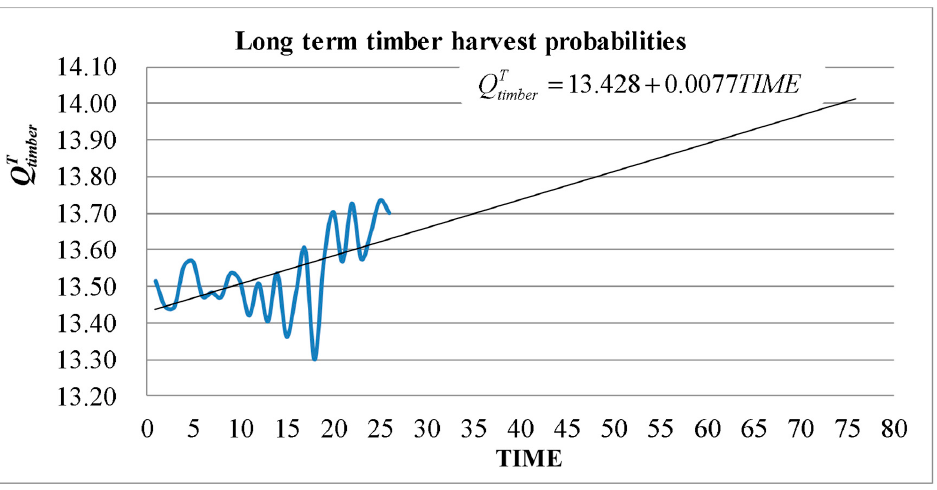
Figure 3. Graph showing the harvest trend developed from historic data for creating a probability distribution describing likely future harvests in Michigan.